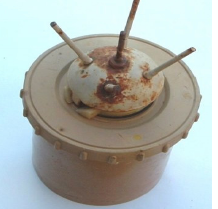
Figure 14 –VALMARA 69-V69 mine Рис . 14 – Мина VALMARA 69-V69 Слика 14 – Мина VALMARA 69-V69